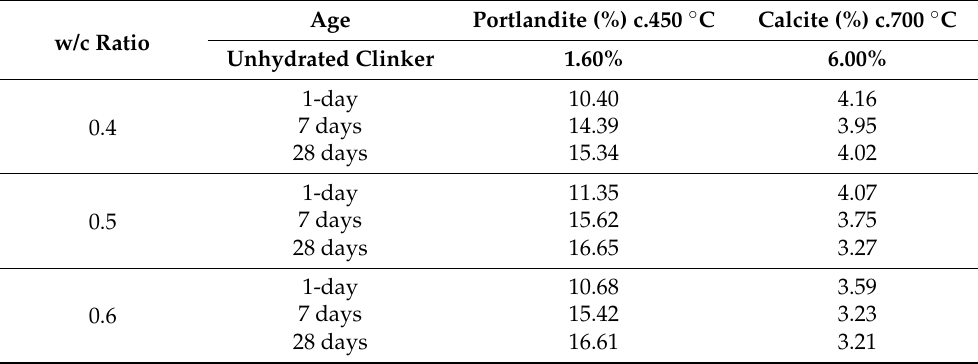
Figure 4. Mass change by TGA at 1, 7 and 28 days.